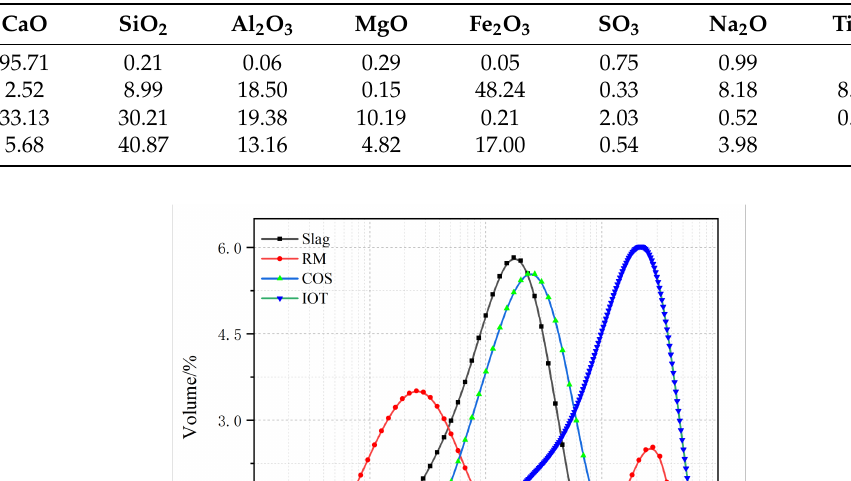
Table 1. Chemical composition of COS, RM, slag, and IOT determined by XRF (wt%).